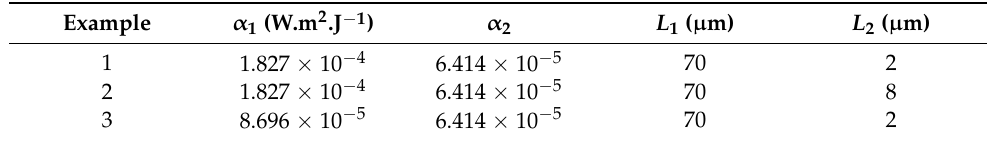
Table 3. Thermal properties for the two-layer